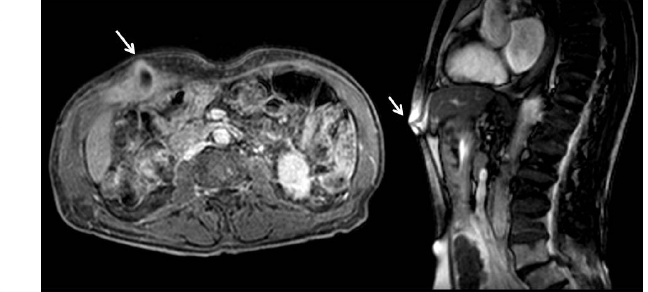
Figure 3. Hepatobiliary MRI. The white arrows show the fistula. From left to right: coronal and sagittal fistula view.